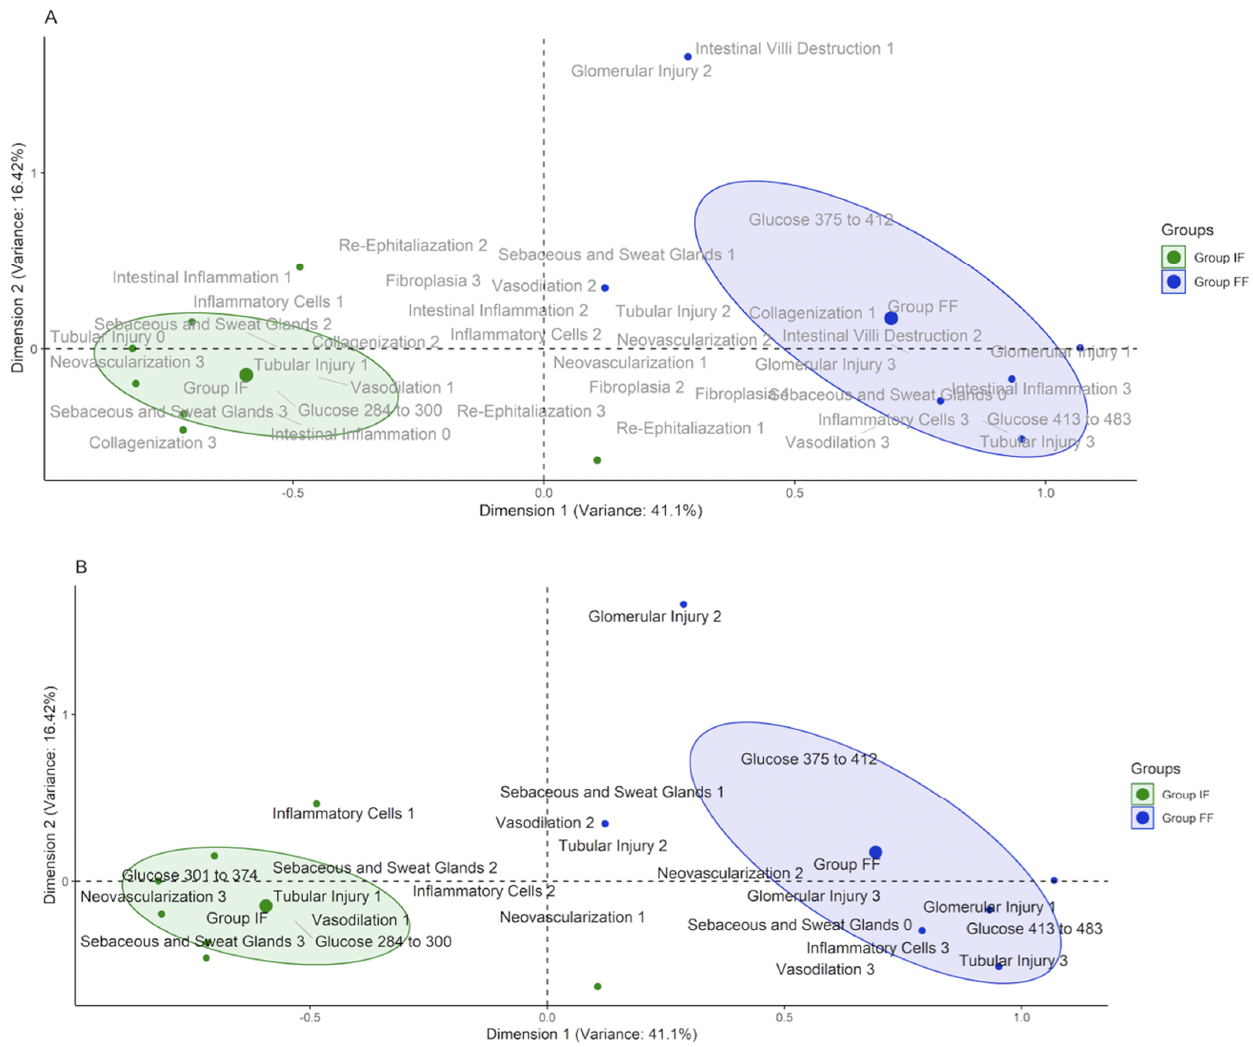
Figure 3. Perceptual map of the first and second dimensions of the multiple correspondence analysis with the qualitative findings of histopathology, experimental groups and glucose classes. In ( A ), all the qualitative variables applied in the analysis are presented, and in figure ( B ) only those with interdependencies by the chi-square test.